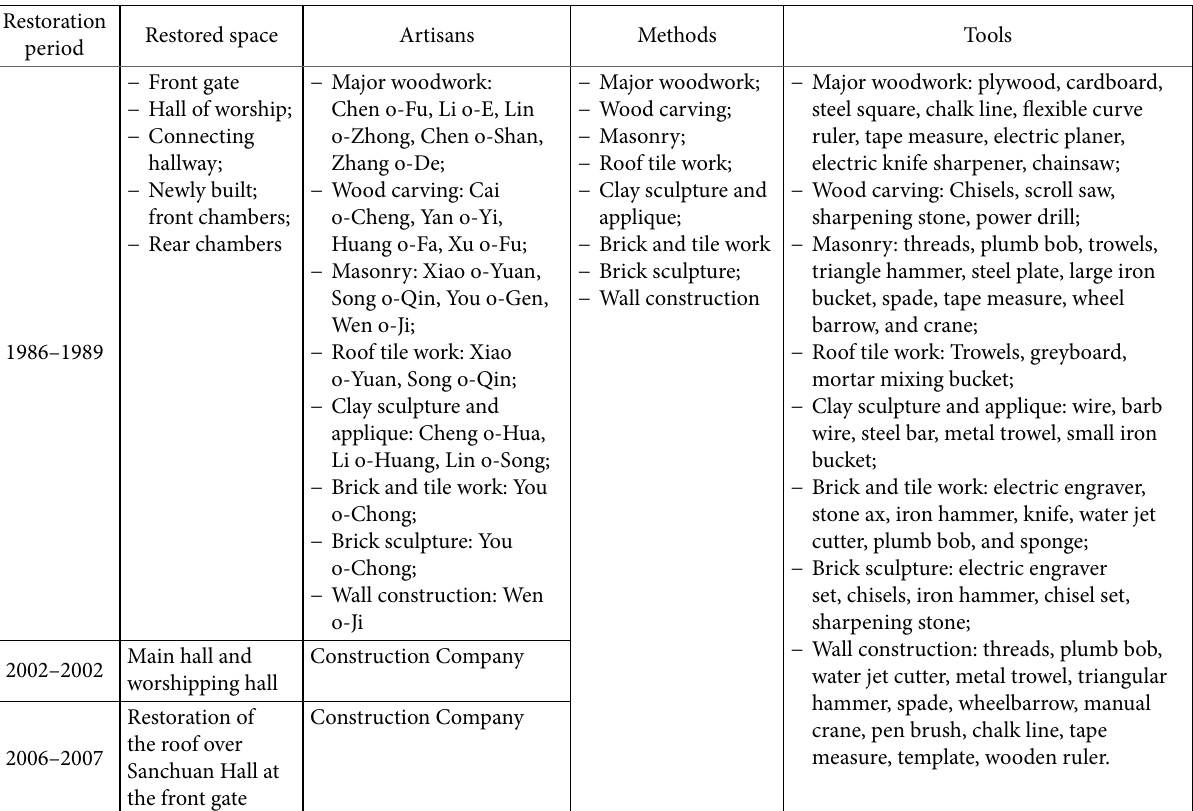
Table 1. Restoration records on Huangxi Academy (source: compiled from Huangxi Academy restoration report and meetings